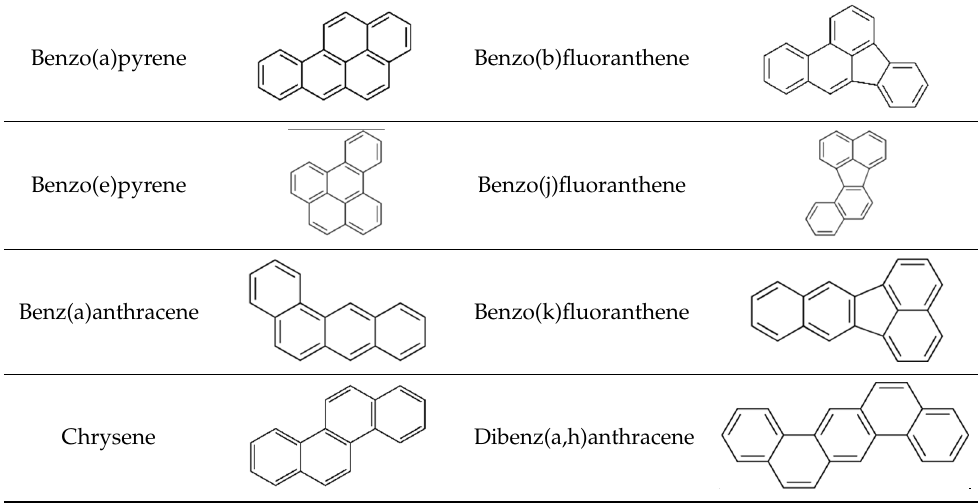
Table 4. List of 8 critical compounds (EU-8 list) identified by the European Chemicals Agency (ECHA) [122].